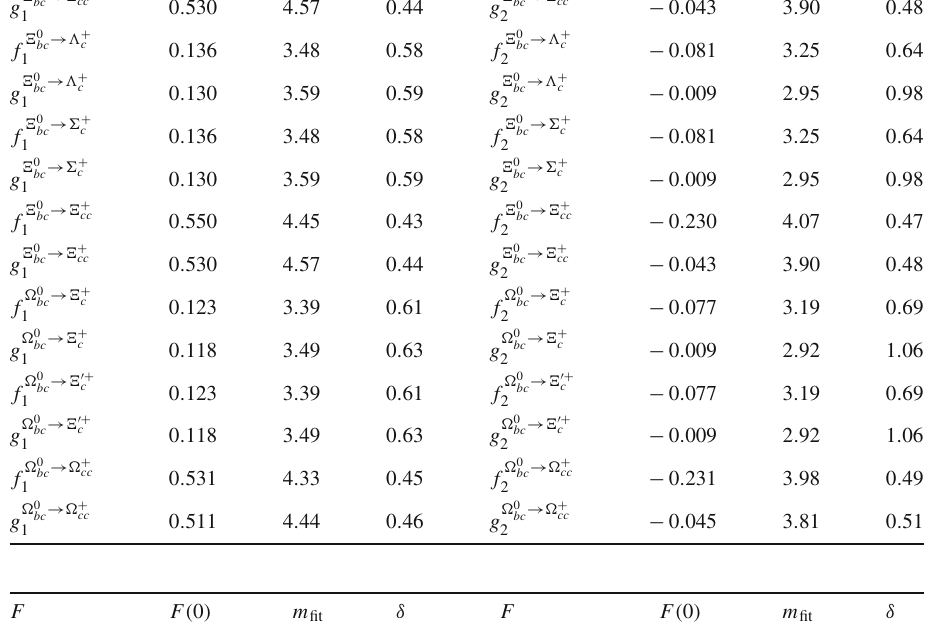
Table 15 Same as Table 9 but for the b decays of bottom–charm baryons with axial vector ( 1 + )